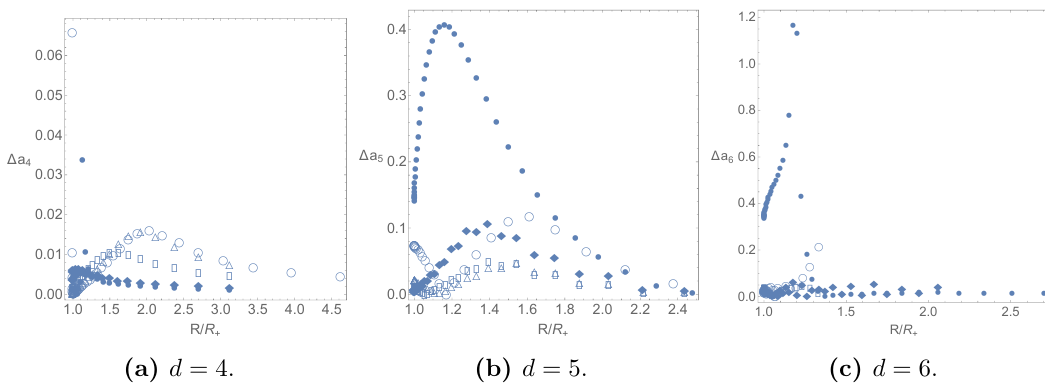
Figure 3. In (a){(c), we plot the error in extracting A d ( r ). Regions with large errors (especially in (c)) correspond to places where our calculated A d ( r ) vanishes while our theoretical A d ( r ), while small, does not vanish exactly. Away from these points, the errors are a few percent or less. Furthermore, in d = 6 as seen in (c), because of large coe(cid:14)cients, errors accumulate quickly. In each plot, the di(cid:11)erent values of R (cid:0) =R + match the values used for the energy densities in (cid:12)gures 4, 5, and 6. In order of increasing R (cid:0) =R + , the symbols are (cid:15) ; (cid:7) ; 4 ; (cid:3) ; (cid:13) . (For d = 6, we don’t use (cid:3)